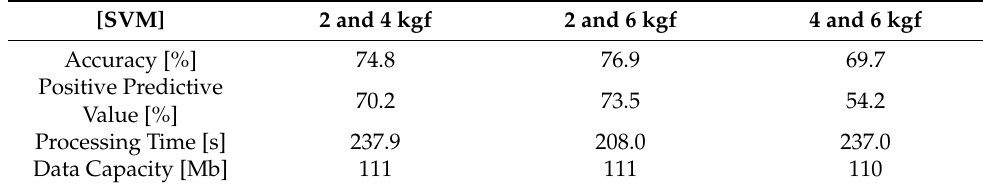
Table 9. Result of sensor data efficiency evaluation for optimal sensor selection of printing roll eccentricity